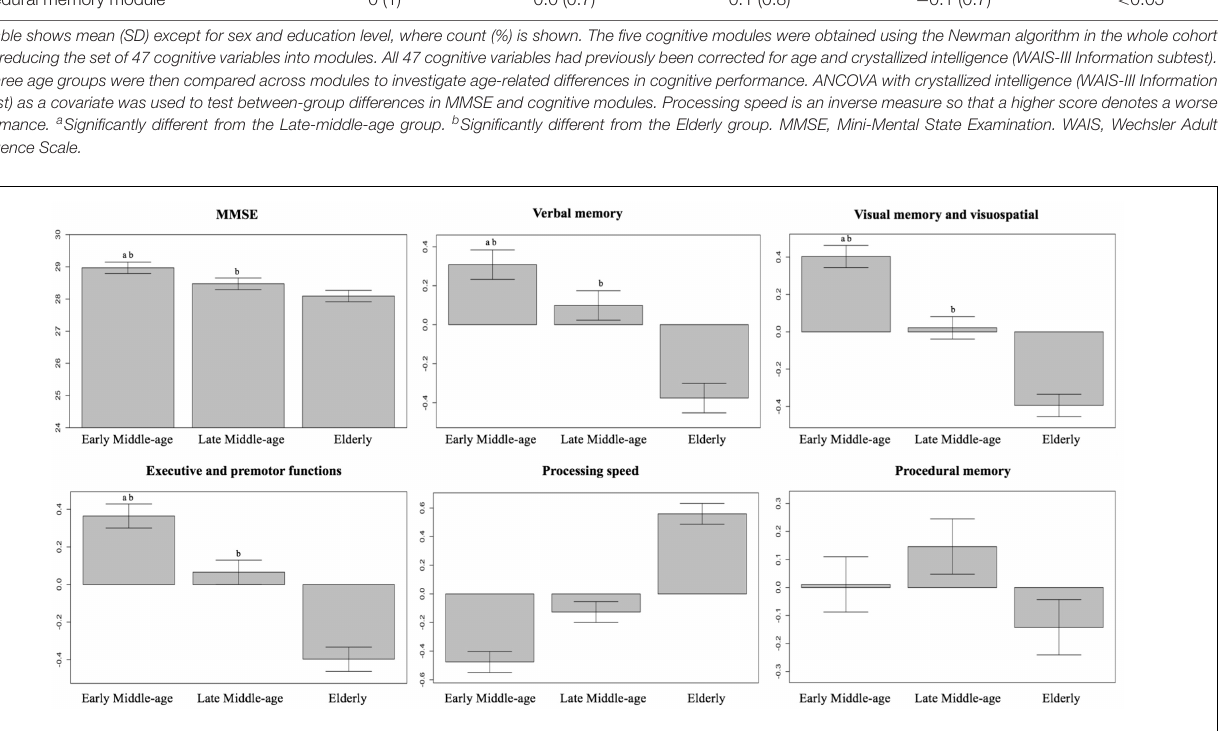
FIGURE 3 | Differences in cognitive performance across age groups. Between-group differences in MMSE and cognitive modules were analyzed using ANCOVA with crystalized intelligence (WAIS-III Information subtest) as a covariate. Processing speed is an inverse measure, so that a higher score denotes a worse performance. Whiskers show 95% confidence intervals. a Significantly different from the late-middle-age group. b Significantly different from the elderly group. MMSE, Mini-Mental State